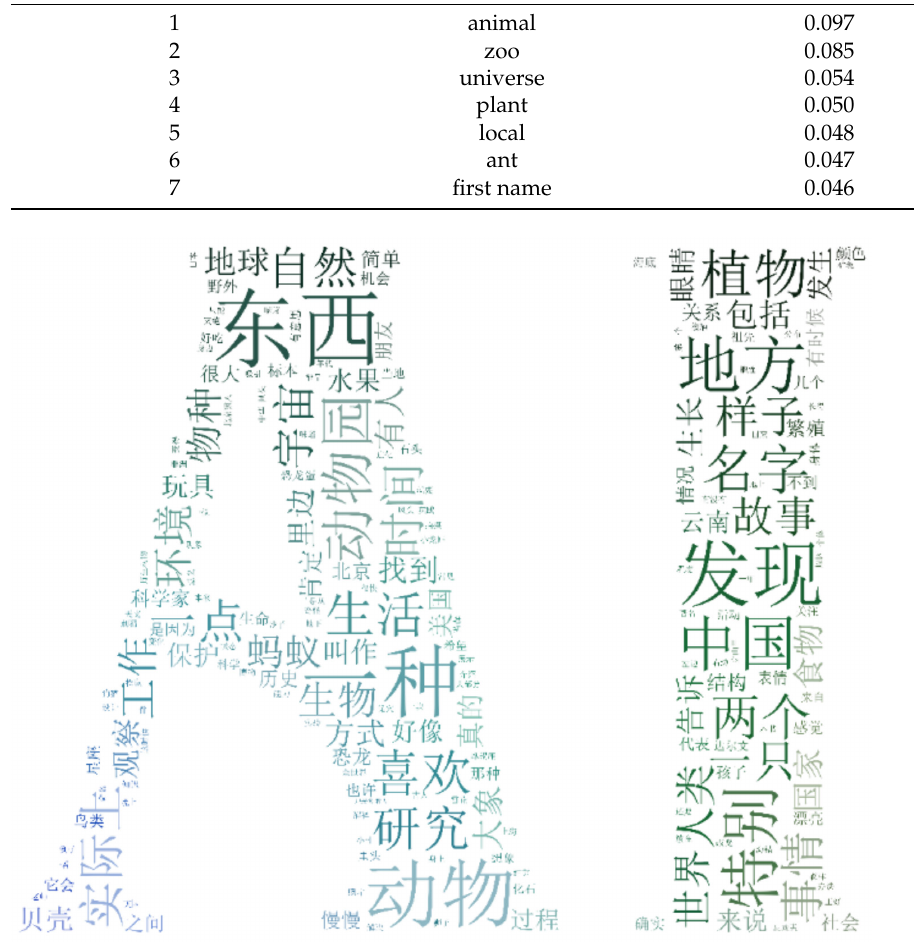
Figure 2. Word cloud diagram for “Natural History category“of YiXi